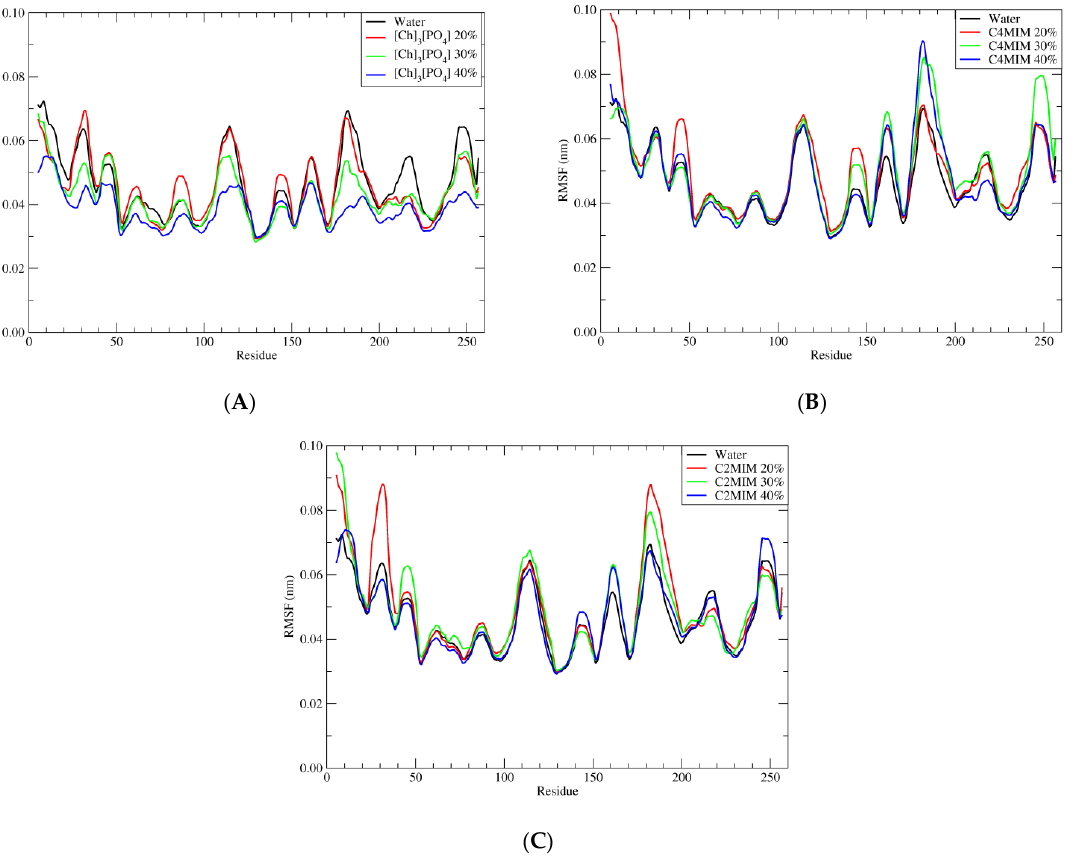
Figure 5. Root mean square fluctuation (RMSF) of wild-type of PETase with water and three different ionic liquids solutions in the presence of ligand BHET. ( A ) Pure water in black; 20% of [Ch] 3 [PO 4 ] in red; 30% of [Ch] 3 [PO 4 ] in green and 40% of [Ch] 3 [PO 4 ] in blue. ( B ) Pure water in black; 20% of [C4MIM][Ac] in red; 30% of [C4MIM][Ac] in green and 40% of [C4MIM][Ac] in blue. ( C ) Pure water in black; 20% of [C2MIM][Ac] in red; 30% of [C2MIM][Ac] in green and 40% of [C2MIM][Ac] in blue.